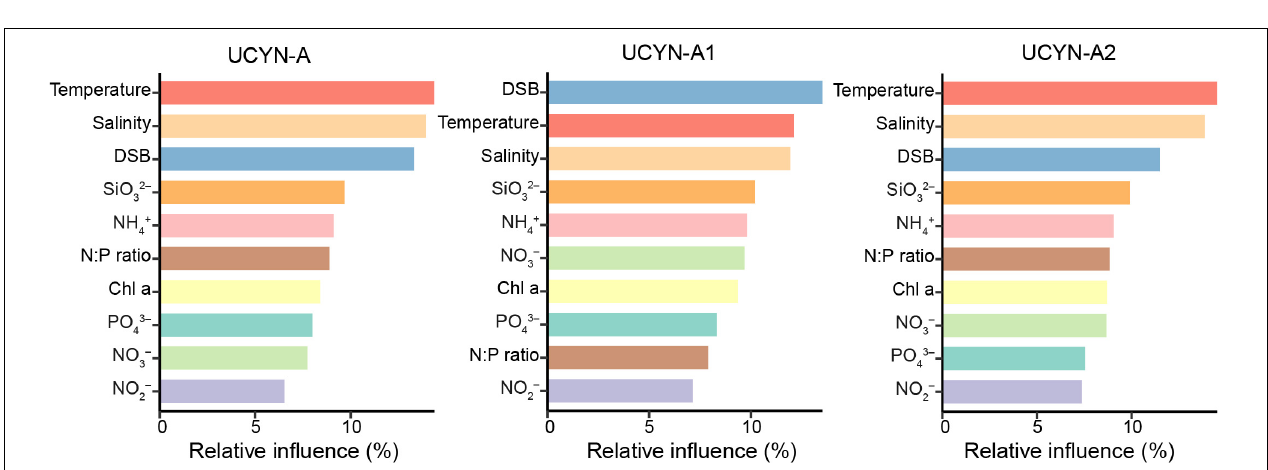
FIGURE 5 | Spatial variation of environmental parameters in three tropical seas. Environmental variables include temperature, salinity, chlorophyll a (Chl a ), silicate (SiO 32 − ), the distance from sea surface to bottom (DSB), ammonium (NH 4 + ), nitrate (NO 3 − ), nitrite (NO 2 − ), nitrate + nitrite (NO x − ), and phosphate (PO 43 − ). Significant differences were investigated using non-parametric Kruskal–Wallis rank-sum tests (* p < 0.05; ** p < 0.01; *** p < 0.001; **** p < 0.0001).